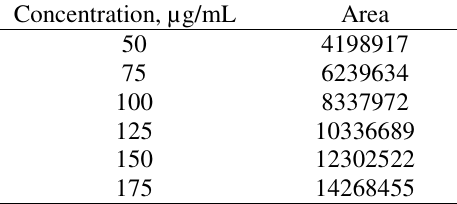
Figure 2. Calibration curve of valsartan. Table 1. Linearity of valsartan.